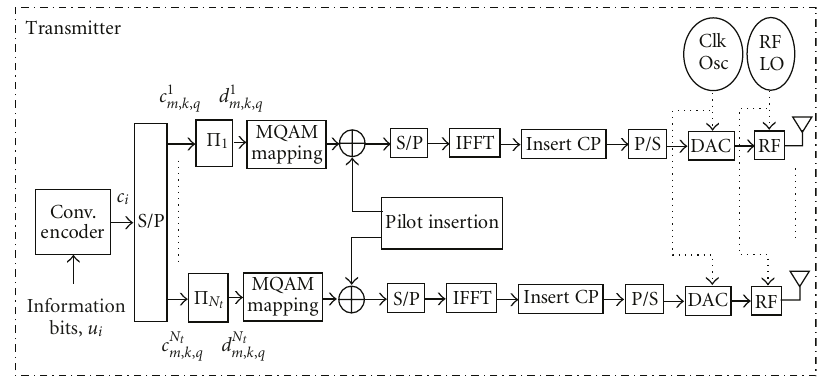
Figure 1: Coded MIMO-OFDM